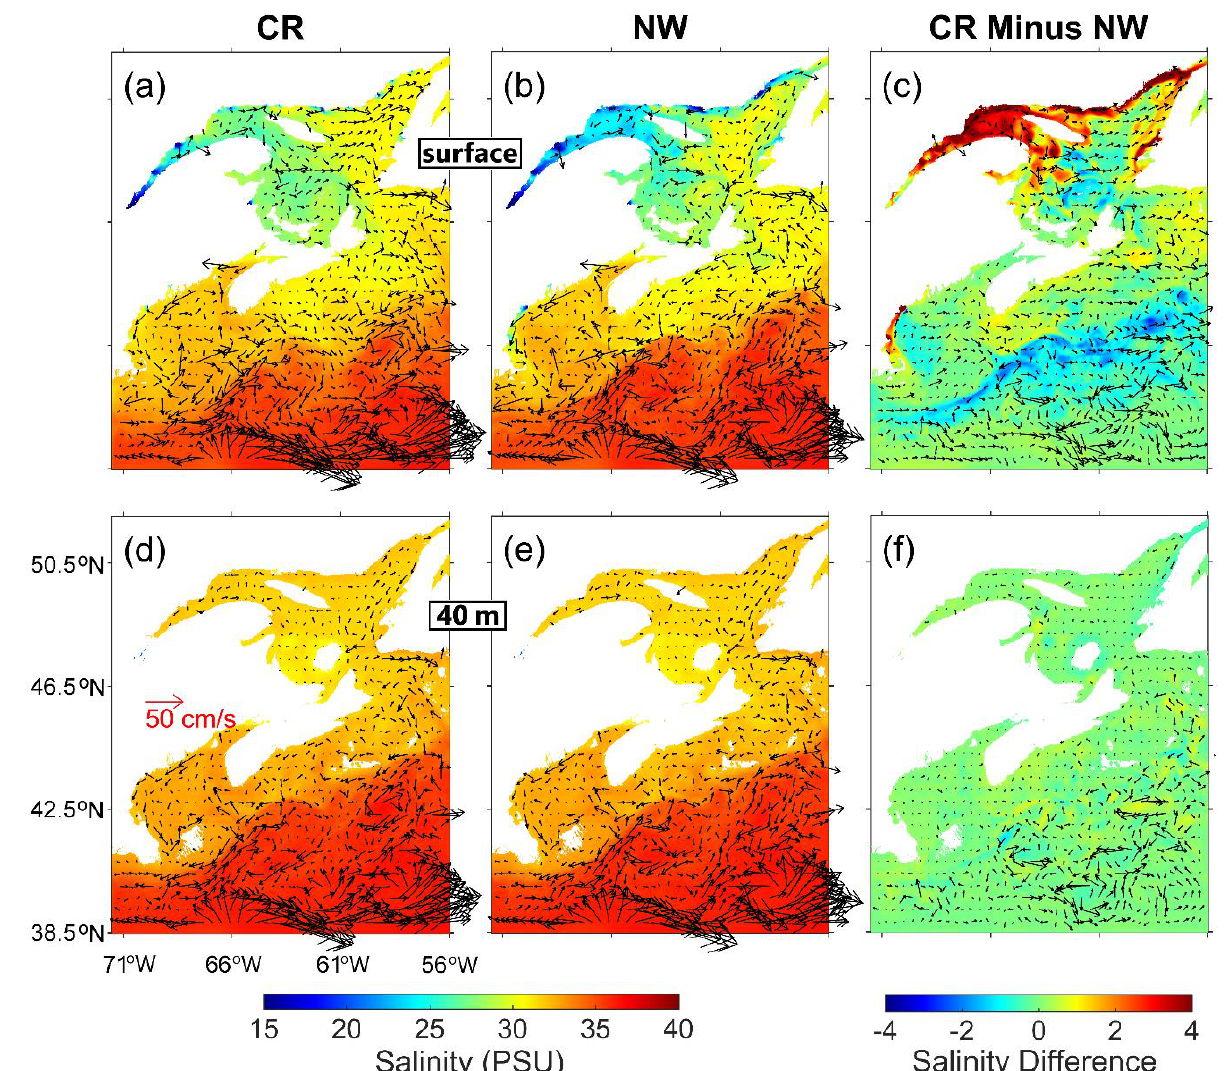
Figure 11. Monthly-mean currents and salinity in August 2018 produced by submodel L2 at ( a , b ) the sea surface and ( d , e ) the 40-m depth over the L2 domain in cases ( a , d ) CR and ( b , e ) NW. Differences in salinity and currents between cases CR and NW at ( c ) sea surface and ( f ) 40 m. For clarity, velocity vectors are plotted at every 14th model grid point. The current velocity vectors are identical to those shown in Figure 9.